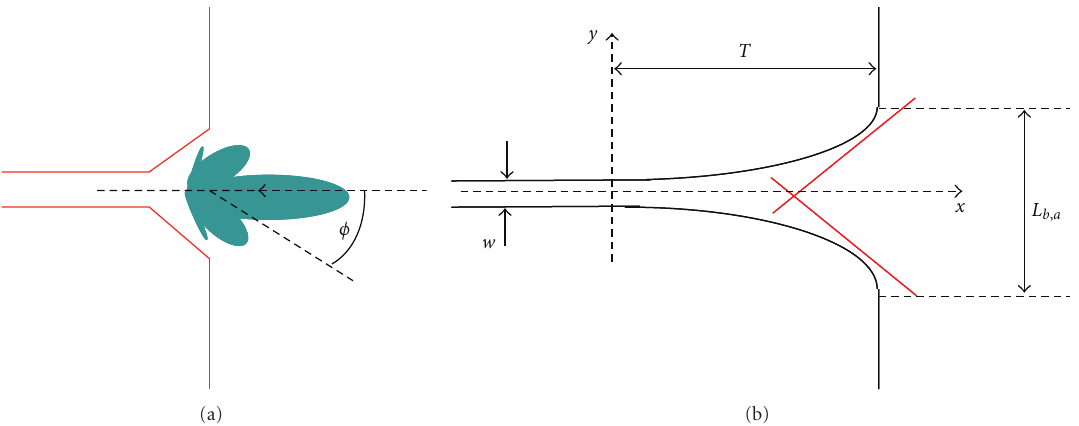
Figure 2: Port modelling. (a) Radiation pattern, (b) Phase center.